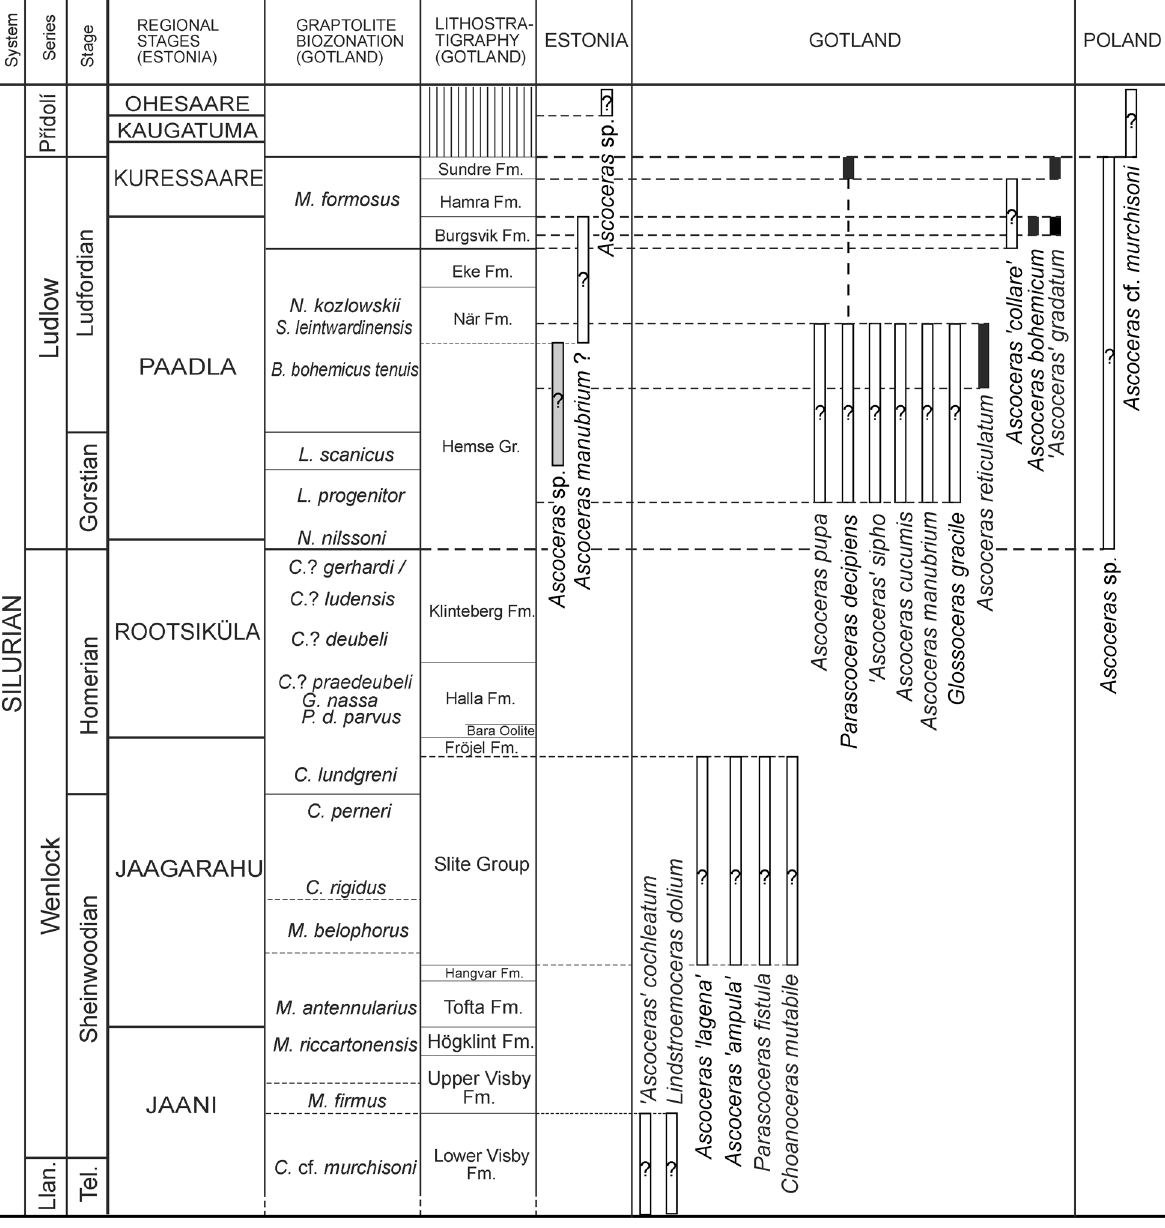
Fig. 3. Stratigraphic distribution of ascocerids on Baltica. The bars indicate possible lower and upper limits of the distribution of the documented specimens. Taxonomic revision of the group is currently being prepared for publication. For this reason the original and/or most recently valid taxonomic names for the genera and species were used for individual